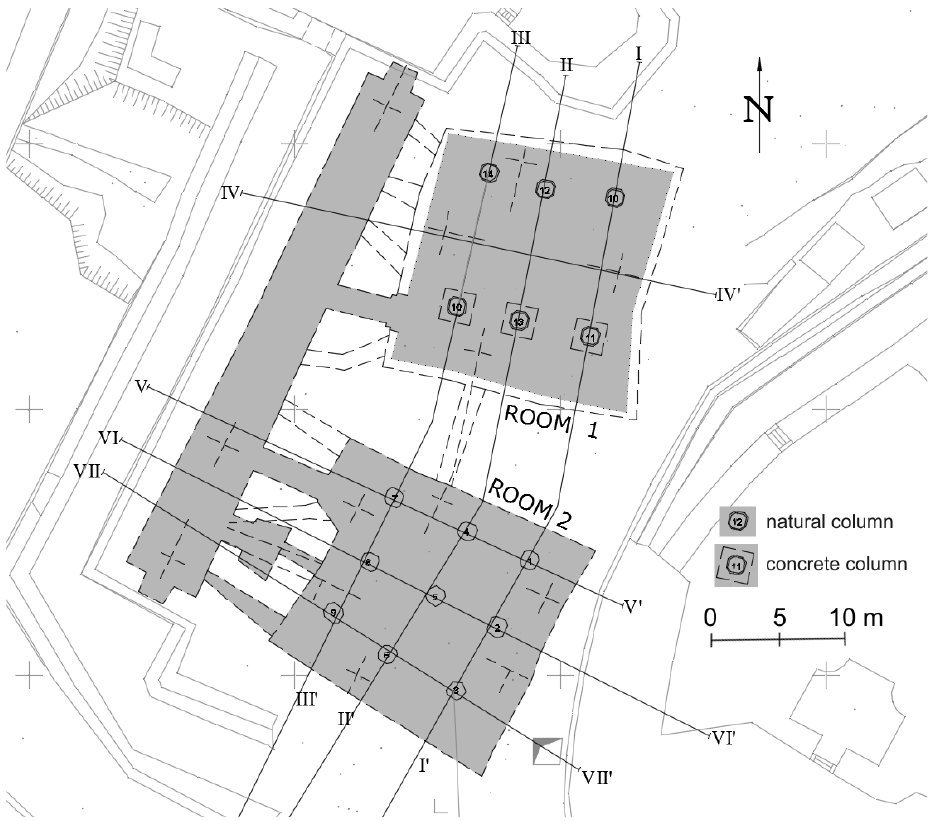
Figure 1. The current layout of the big gunpowder depots of the Kalemegdan fortress.